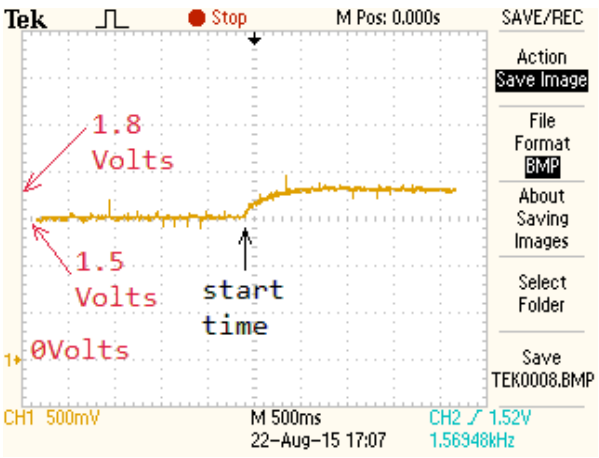
Figure 12. Output response of a FSMSS.